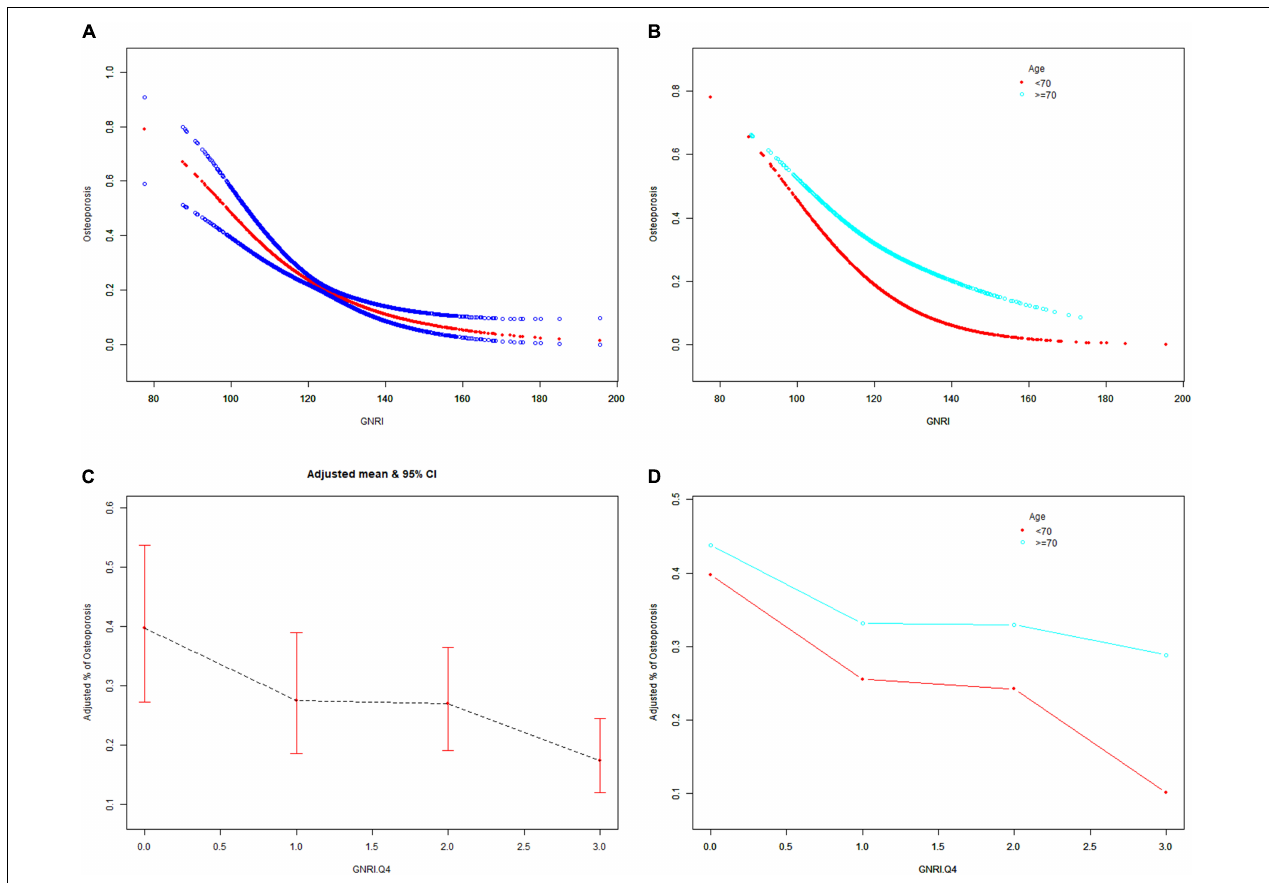
FIGURE 4 | The associations of GNRI and GNRI.Q4 with the risk of osteoporosis. Age [ (A,C) were applicable, (B,D) were not applicable], race/ethnicity, BMI, educational level, marital status, PIR, smoked at least 100 cigarettes, hypertension status, diabetes status, ever use prednisone or cortisone daily, ever use female hormones, had a hysterectomy, moderate or vigorous activity, and postmenopausal period were adjusted. BMD, bone mineral density; GNRI.Q4, geriatric nutritional risk index quartiles; PIR, poverty income ratio; BMI, body mass